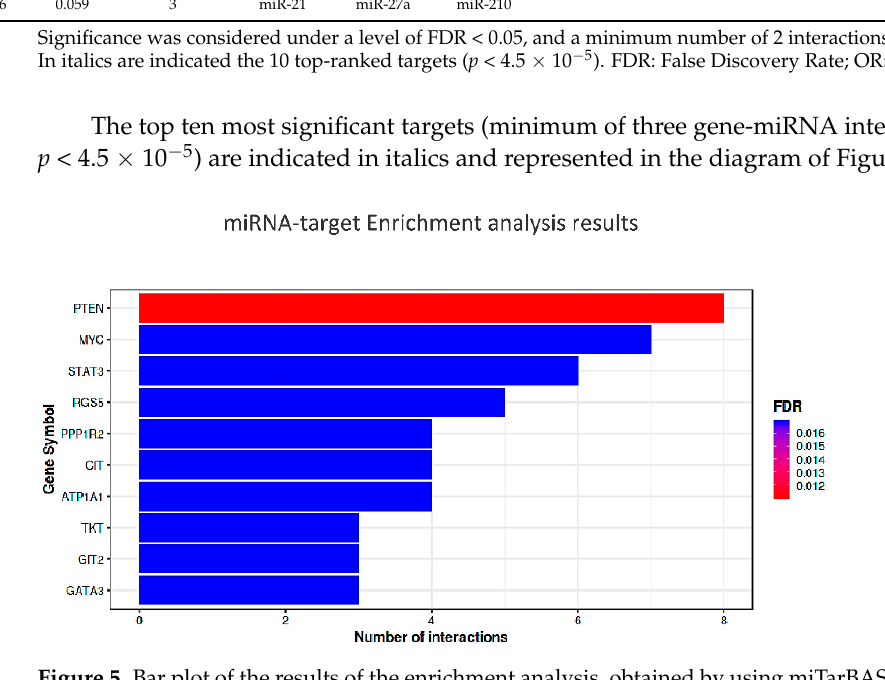
Figure 5. Bar plot of the results of the enrichment analysis, obtained by using miTarBASE as reference dataset. In the Y-axis are reported the top ten target genes of the submitted miRNAs, while the X-axis represents the number of miRNAs targeting them. The color code reflects the adjusted p -values (FDR) increasing from red to blue. The threshold for the minimum number of miRNA-target interactions was set up to 2.